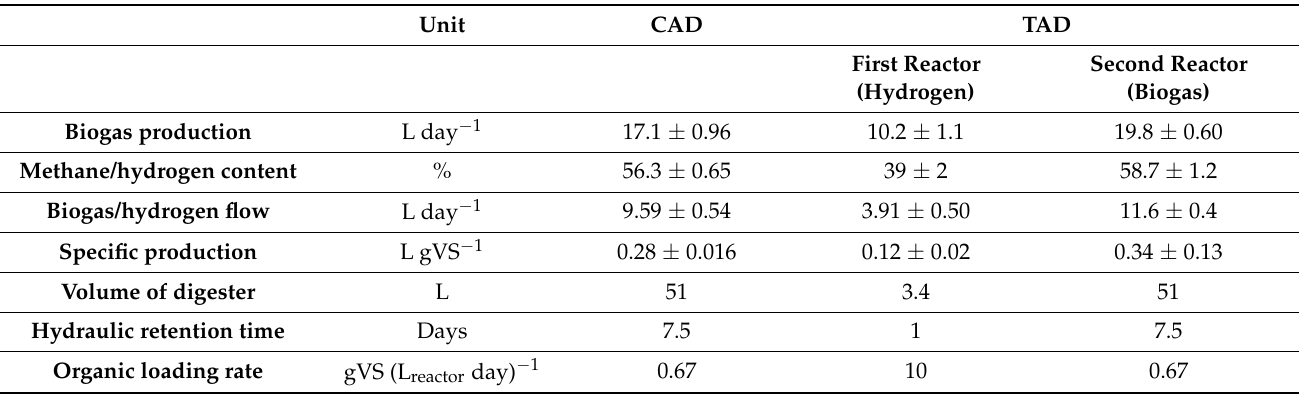
Table 1. Summary of experimental results of CAD and